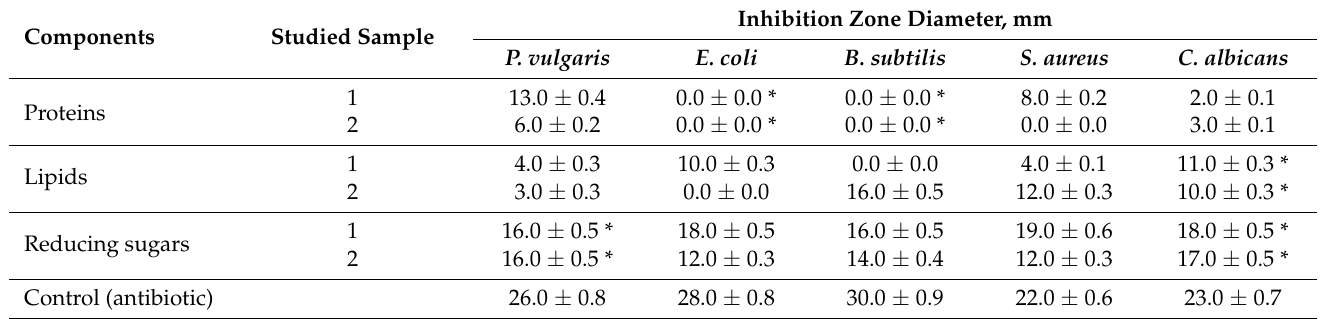
Table 4. Results of antibacterial activity of proteins, lipids, and sugars obtained from